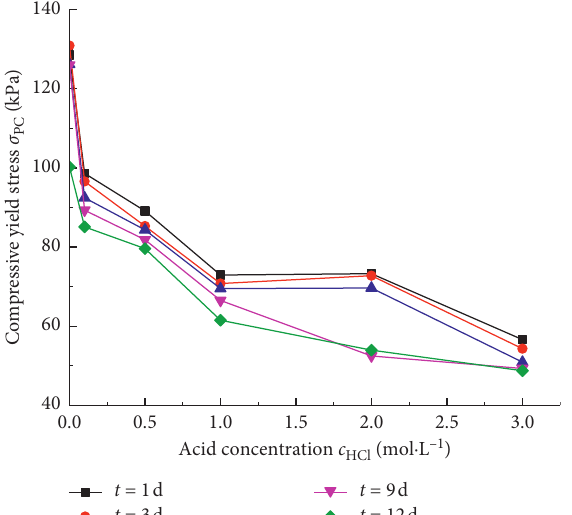
Figure 7: Compression yield stress change curve.